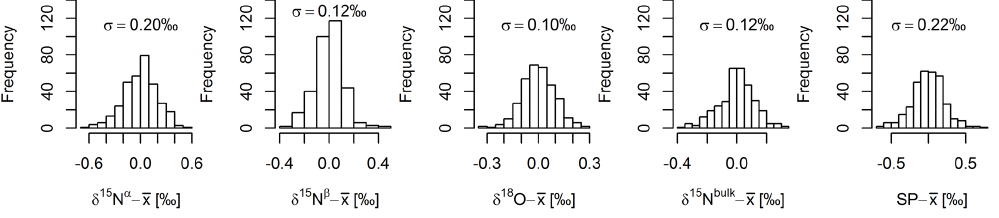
Figure 1. Long-term stability (standard deviation σ ) derived by target gas injections ( n = 331) over a 3-month period. As two target gas tanks were used, histograms show deviation of respective tank means, ¯ x , for δ 15 N α , δ 15 N β , δ 18 O, δ 15 N bulk and